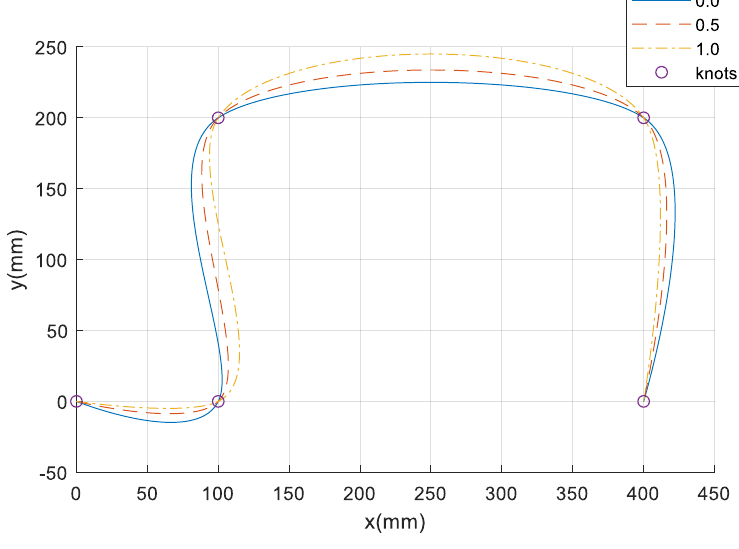
Figure 8. Path for five knots according to 𝛽 in the task #2.